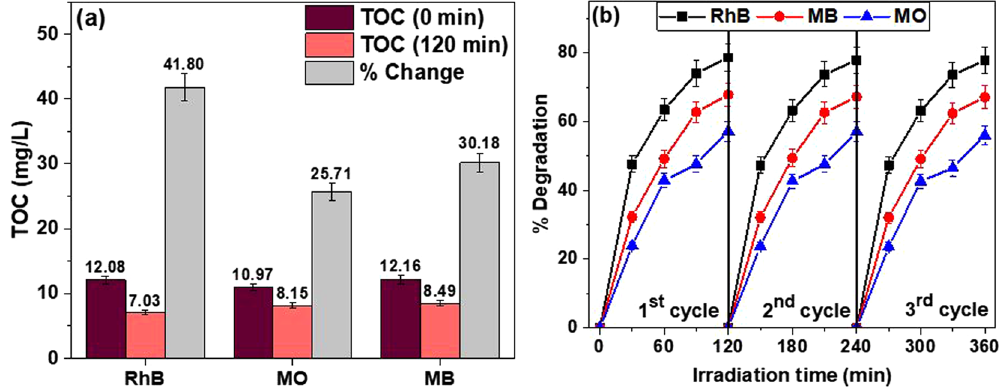
Figure 14. ( a ) Total organic carbon (TOC) of different dyes with 10C800 before and after the 120 min visible irradiation; ( b ) Reusability of 10C800 as photocatalyst under visible